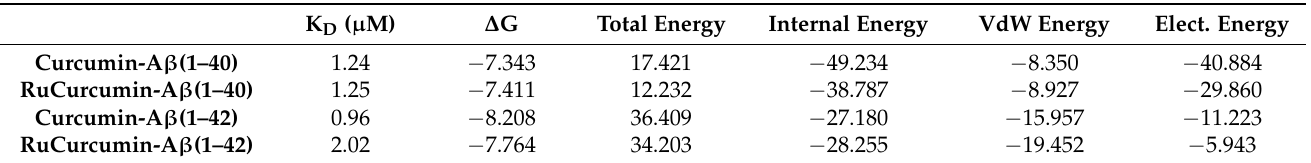
Table 1. Computed affinities and energy contribution (kcal/mol) values for the complexes formed between the molecules of interest and amyloid 1–40 and 1–42 monomers. K D ( µ M) ∆ G Total Energy Internal Energy VdW Energy Elect.